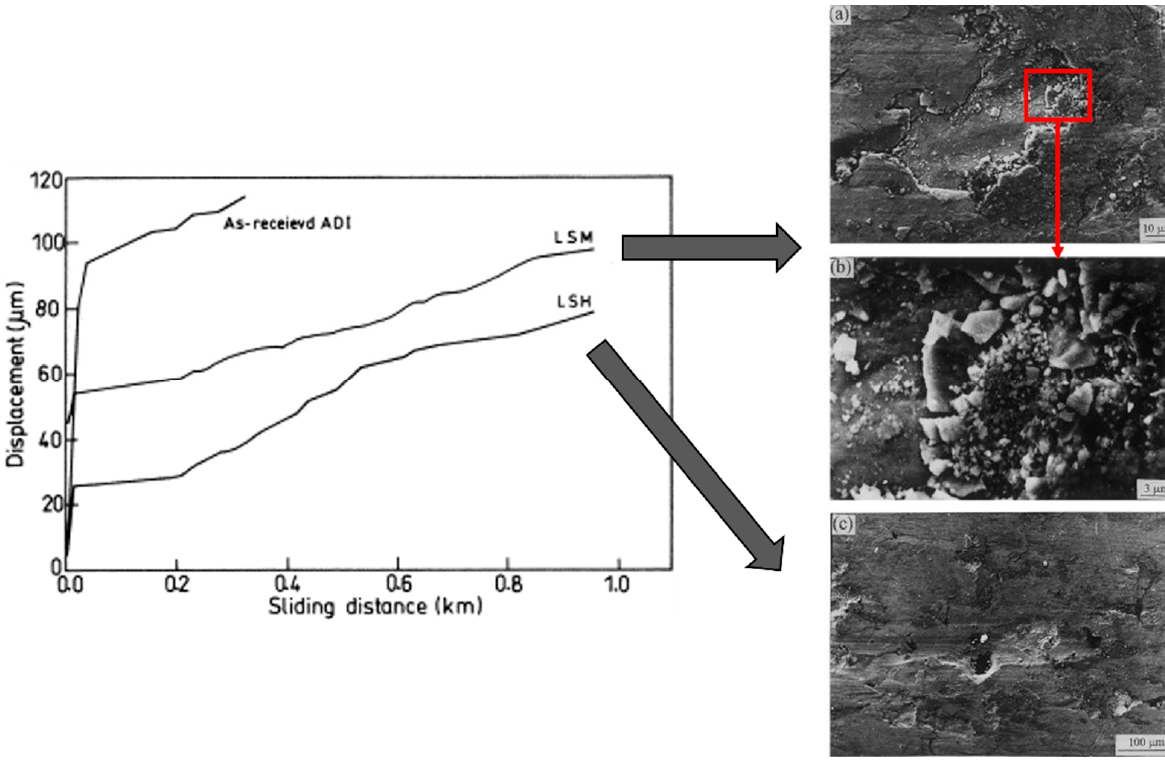
Figure 12. Evolution of displaced material as a function of sliding wear distance for as-received and laser-treated ADI samples (left); SEM micrographs of worn surfaces (right) for ( a ) LSM treated ADI, ( b ) magnified view of wear debris of ( a ), and ( c ) LSH-treated ADI (Reprinted with permission from ref. [58]. 2001 Elsevier).